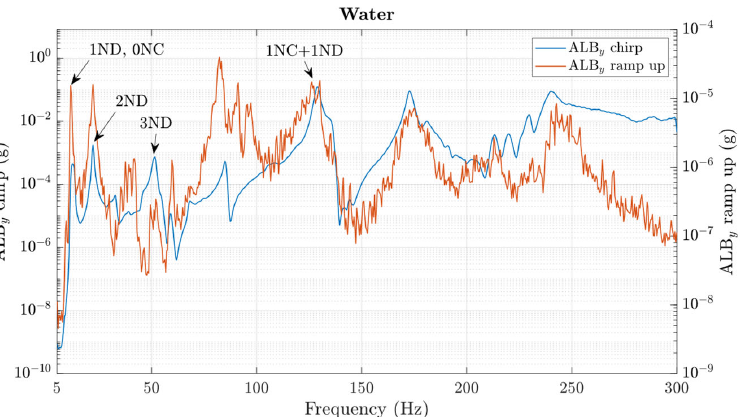
lower bearing in a radial direction, ALBy, during a ramp ‐ up, in orange, and during a chirp excitation using the PZT patch, in blue. These spectra show that most of the natural fre ‐ quencies of the disk corresponding to the 1ND and 0NC at around 13 Hz, the 2ND at 22 Hz, the 3ND at 51.8 Hz and the 1NC + 1ND at 128.9 Hz were accurately measured by the off ‐ board accelerometer. It is probable that the other natural frequencies of the disk, cor ‐ responding to the 4ND and 1NC, were also excited by the mechanical imbalance and its harmonics, but they were not measured with precision from the bearing housing.